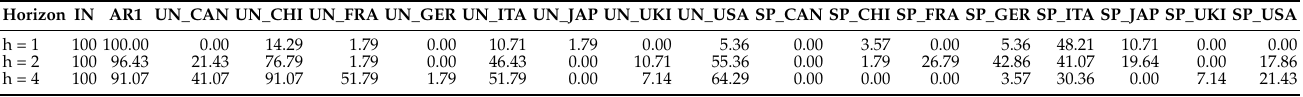
Table 6. Inclusion of predictors in the Lasso